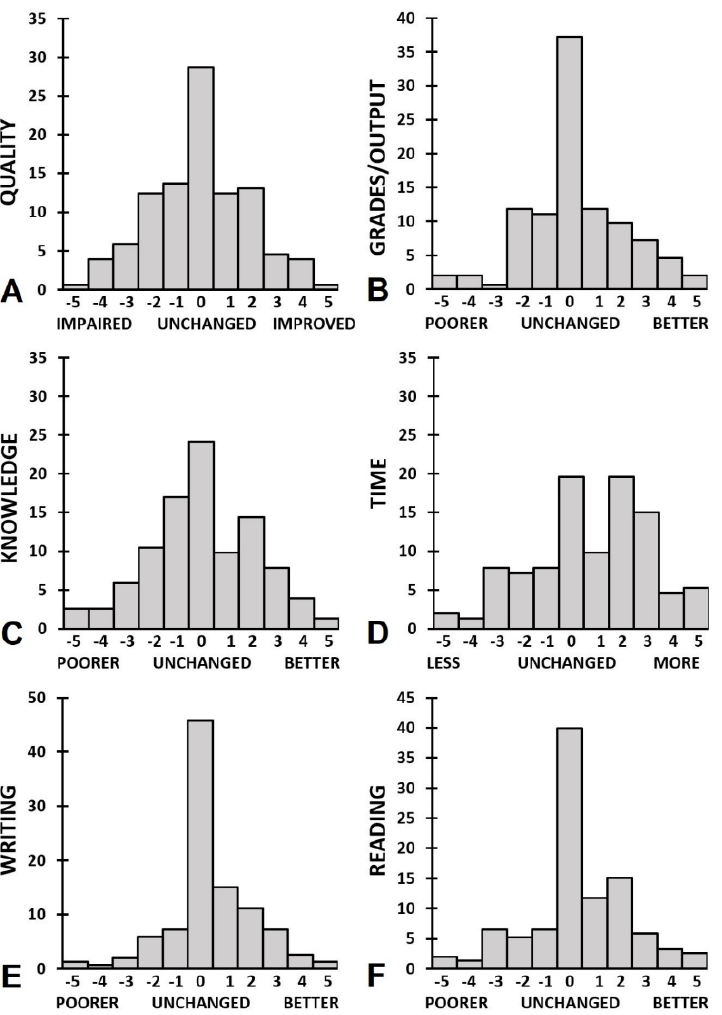
Figure 4. The impact of the COVID-19 pandemic on academic performance. The distributions of percentages endorsement are shown for ( A ) overall performance quality, ( B ) study grades/output, ( C ) knowledge, ( D ) time, ( E ) writing, and ( F ) reading.